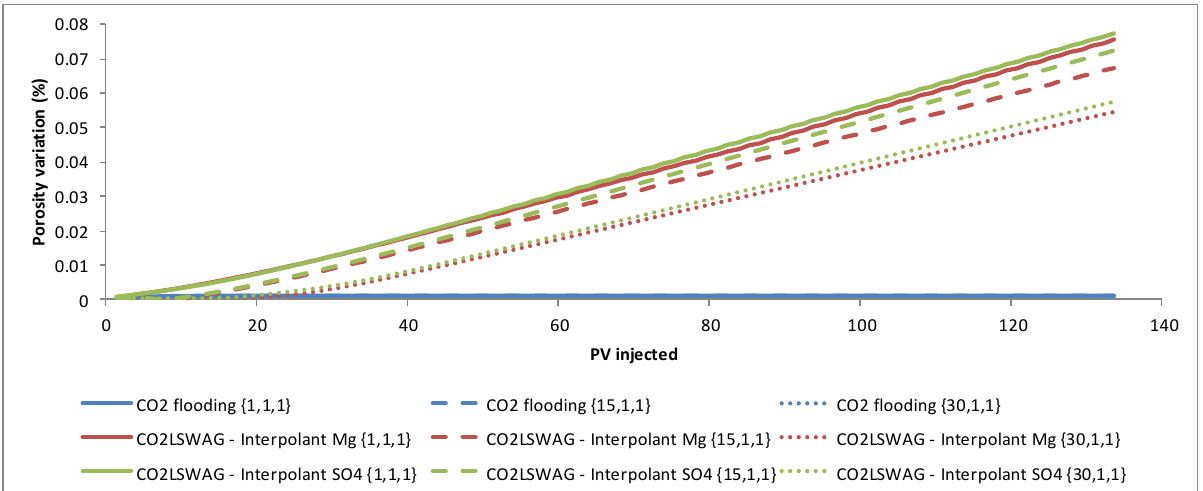
Figure 6. Porosity variation at the coordinates {1,1,1}, {15,1,1}, and {30,1,1}, representing the injection, the central point of the core, and the production.